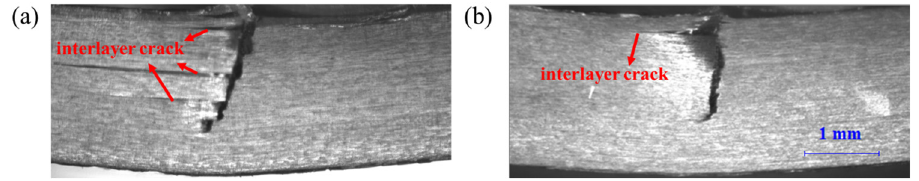
Figure 7: Macroscopic failure process through third direction of ( a ) composite and ( b ) Z - pin composite after moisture condition for 7